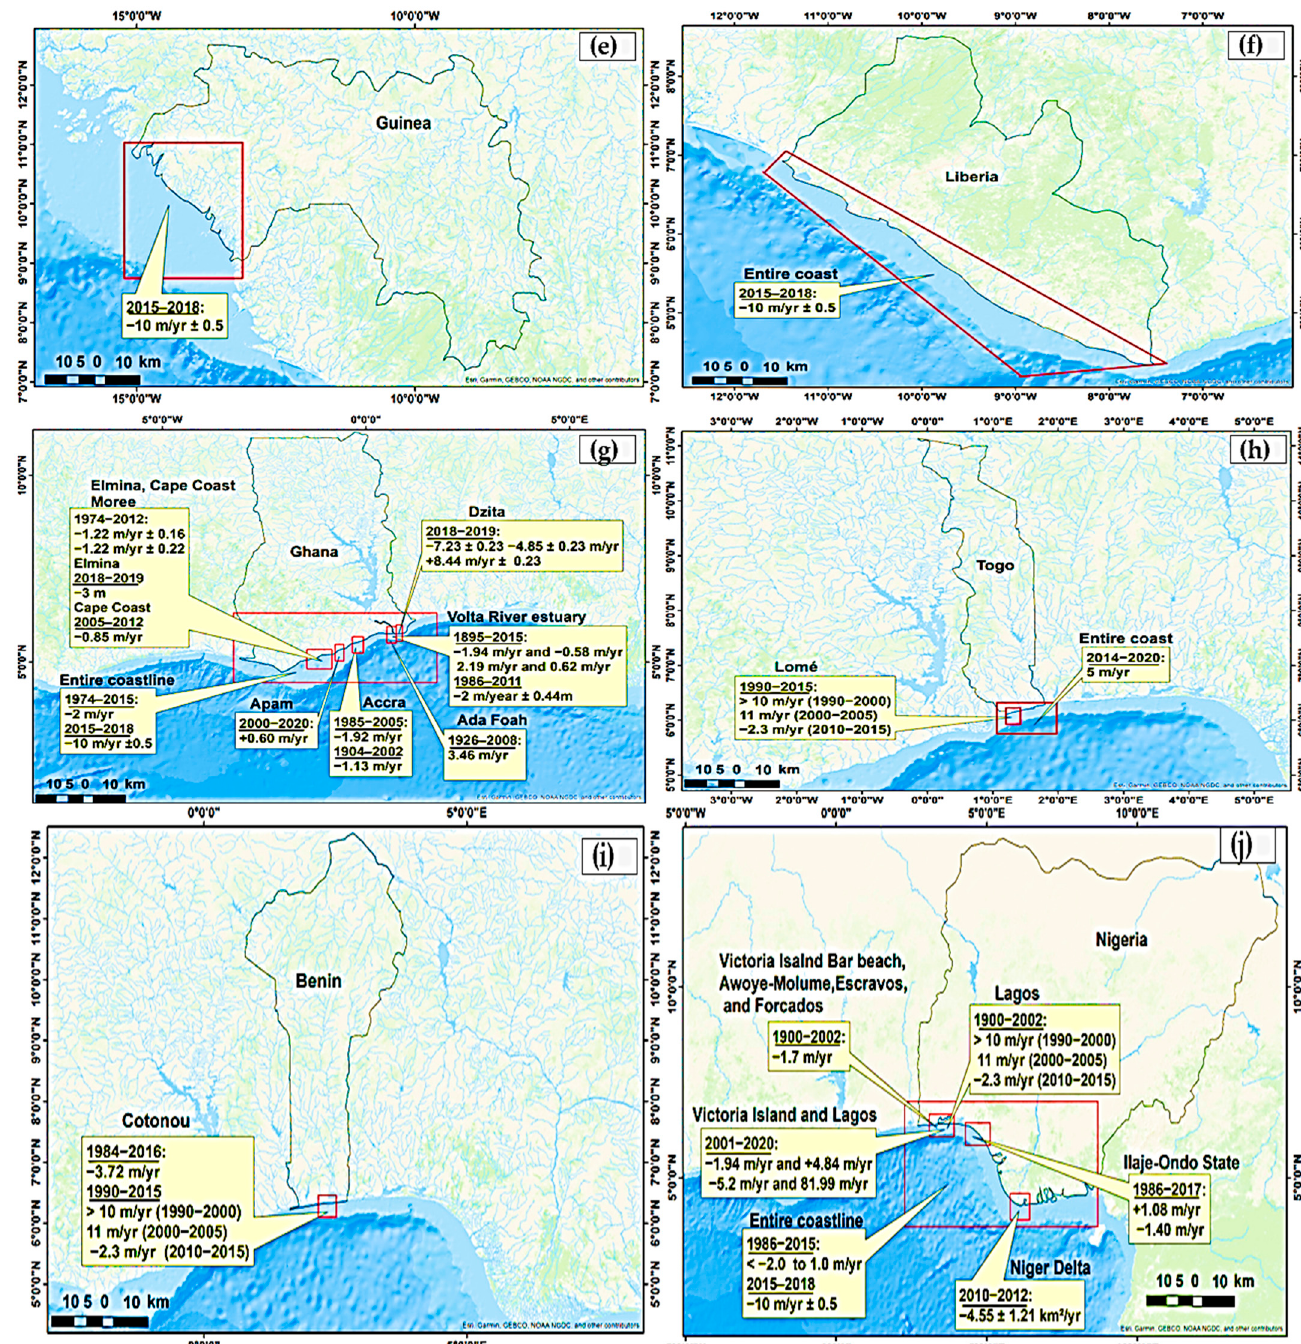
Figure 4. A graphical representation of the shoreline change rates found in the literature for Cape Verde ( a ), Senegal ( b ), Gambia ( c ), Guinea-Bissau ( d ), Guinea ( e ), Liberia ( f ), Ghana ( g ), Togo ( h ), Benin ( i ), and Nigeria ( j ). Note: Erosion and accretion are represented by the negative and positive values, respectively. The sign (±) indicates the degree of uncertainty. The red, rectangular box denotes the areas of application mentioned in the literature used in this review.